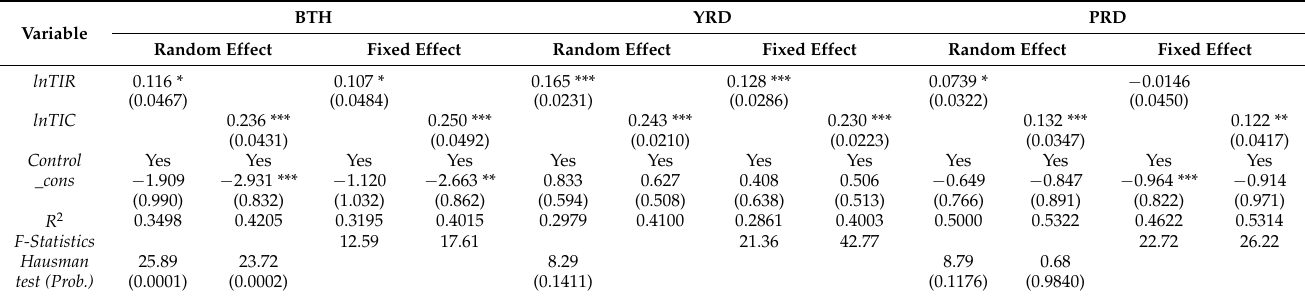
Table 6. Panel regression results of TIR and TIC in each urban